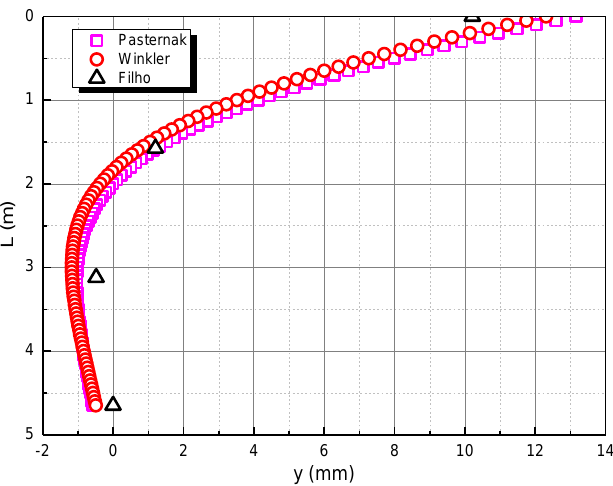
Figure 3. Comparison of horizontal displacement of pile body.